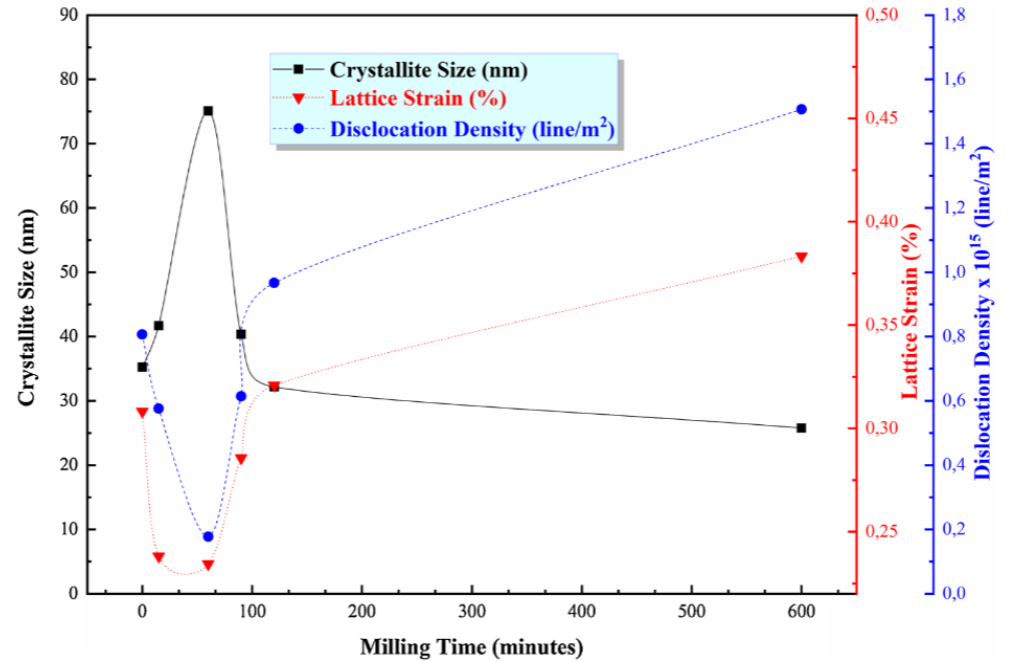
Figure 10. The variation of the crystallite size, lattice strain, and dislocation density of TiC/AA7075 powders estimated from XRD curves. Reprinted with permission from [126]. Copyright 2021 Elsevier.